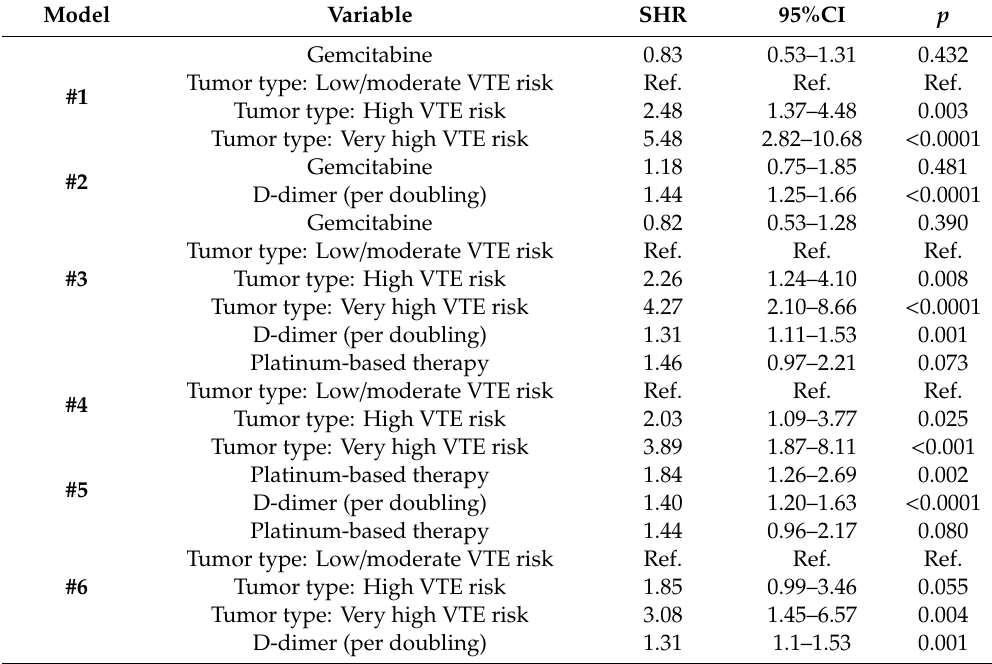
Table 2. Baseline characteristics of study